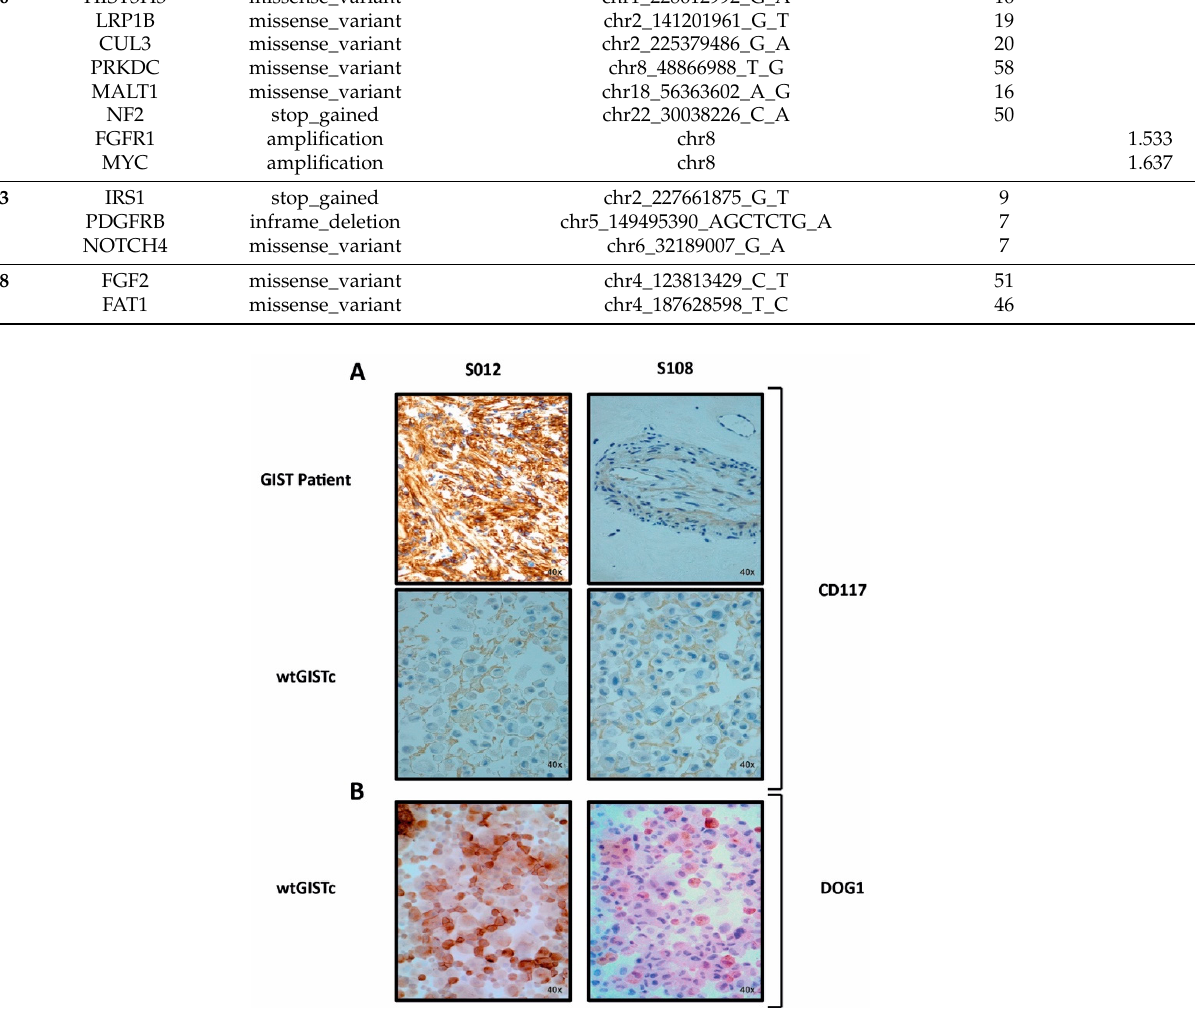
Figure 2. CD117 and DOG1 expression in GIST samples and corresponding wtGISTc. CD117 ( A ) and DOG1 ( B ) immunohistochemistry staining (magnification 40×) in two representative surgical samples from GIST patients (diffuse expression on the left, focal expression on the right) and the corresponding wtGISTc. S012 and S108: unique patient numbers. We confirmed the genetic consistency between wtGISTc ( n = 11) and their original surgical samples by DNA sequencing. All wtGISTc resulted KIT/PDGFRA WT; additional genetic alterations, detected by using a targeted panel of 523 cancer-related genes, are shown in Table 1. Table 1. Mutational profile of wtGISTc as assessed by targeted sequencing. VAF: Variant Allele Frequency. wtGISTc